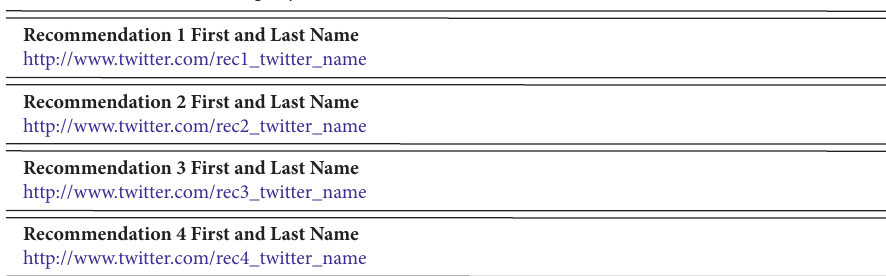
Figure 3: Anonymized representation of the first set of recommendations in a survey deployed on Google